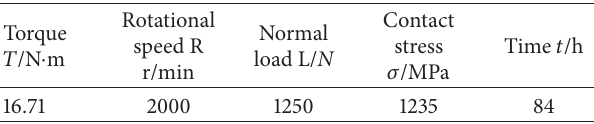
Table 3: Operating conditions in gear